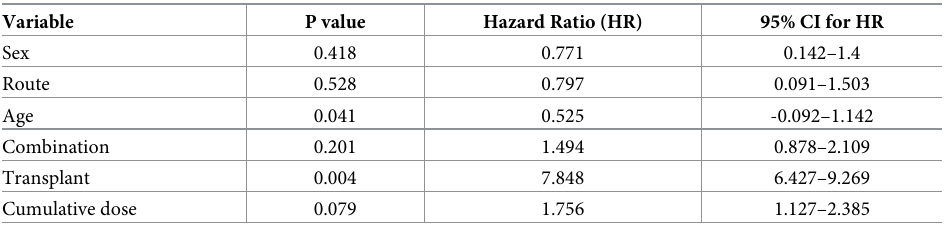
Table 4. Univariate cox regression analysis for NDMM